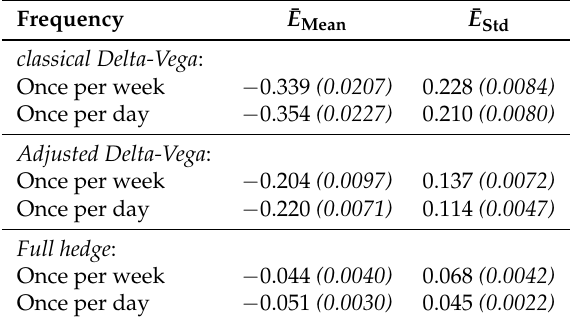
Table 1. Hedge errors of the different hedging strategies. The standard errors of the estimates are given in